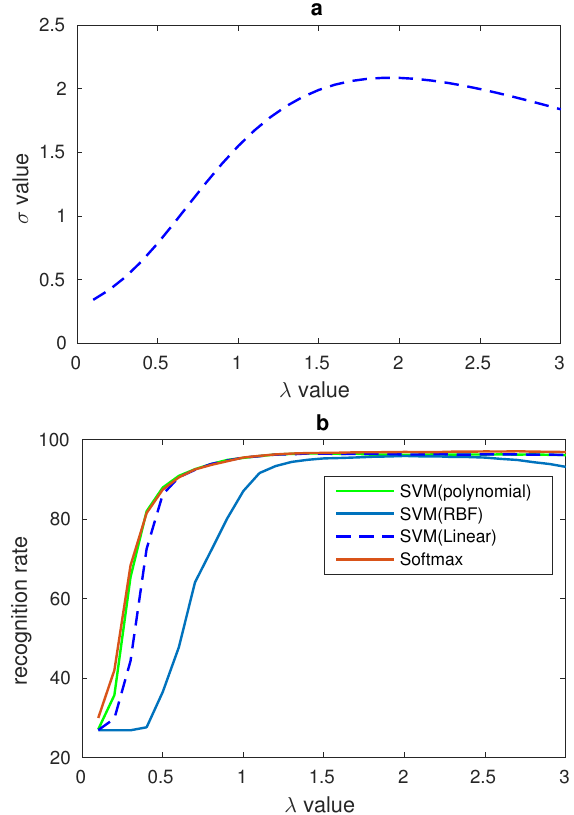
Figure 9. ( a ) Relationship between λ and σ on CK+ database; ( b ) Relationship between λ and recognition rates from different classifiers on CK+